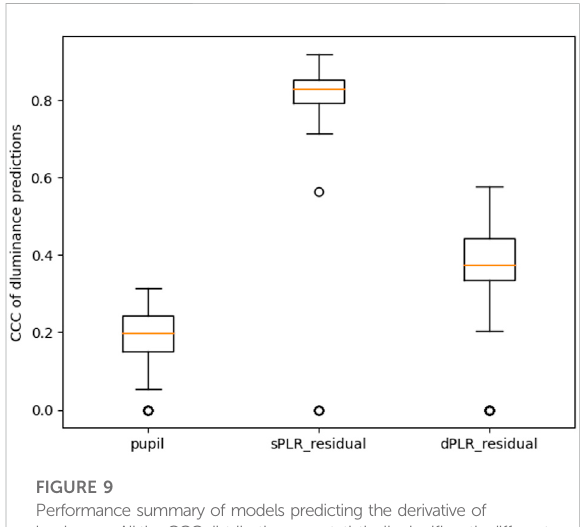
FIGURE 10 Performance summary of models predicting the arousal indicator. All the CCC distributions are statistically signi fi cantly different from each other (paired Wilcoxon test with p-value less than0.001forallexceptbetweenpupilandluminancewhose p-value is less than